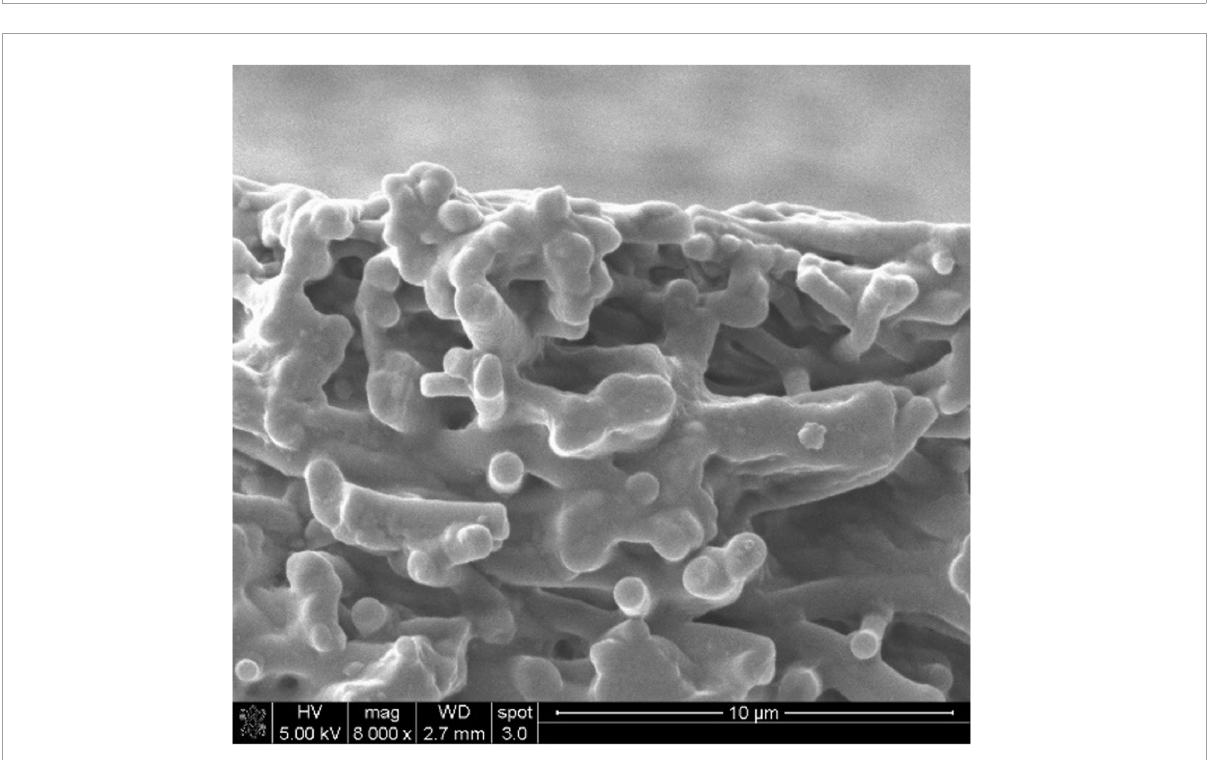
valve leaflets preparation. Using the electrospinning unit model NEW-BM (NaBond), these polymers were processed to the multilayer fibrous and semi-fibrous layers mounted on stents. Polymeric materials are attached to the metal frame using the